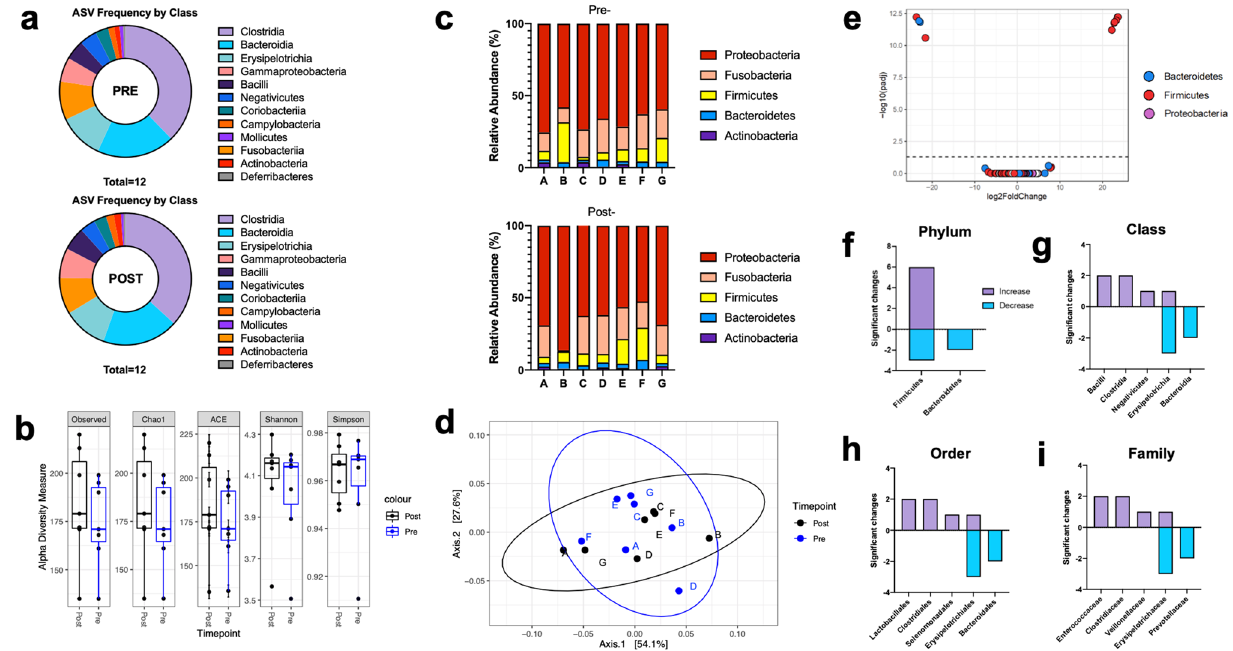
Figure 6. No changes in the fecal microbiota were associated with fenofibrate treatment in diabetic dogs. ( a ) Frequencies of amplicon sequence variants (ASVs) in fecal samples collected pre- and post-fenofibrate treatment. ( b ) Evaluation of alpha diversity using Observed, Chao1, ACE, Shannon, and Simpson indices. ( c ) Bar chart showing relative abundance of bacterial phyla among samples collected before and after fenofibrate administration in each of 7 dogs ( A-G) with experimentally-induced DM. ( d ) Weighted UniFrac PCoA analysis of microbiota composition in identical animals pre- and post-fenofibrate treatment. Circles represent regions of 95% confidence. ( e ) Volcano plot representing differentially abundant bacterial phyla where P < 0.05. Numbers of differentially abundant bacterial ( f ) phyla, ( g ) class, ( h ) order, and ( i ) family between pre- and post- fenofibrate samples DESeq2 with phyloseq and omu on R